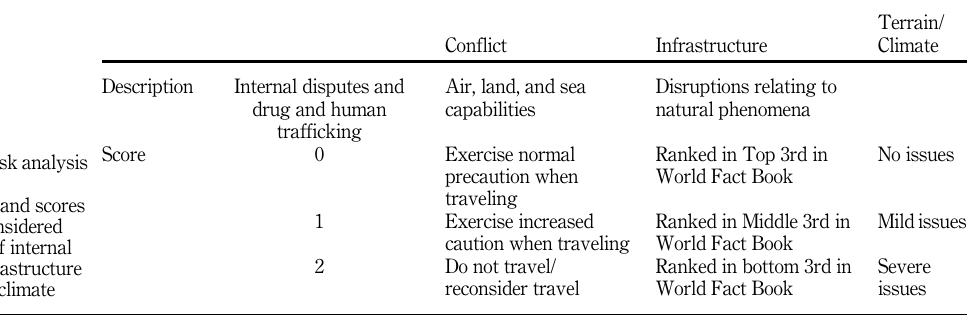
Table 2. Resilience risk analysis framework: Description and scores for three considered categories of internal conflict, infrastructure and